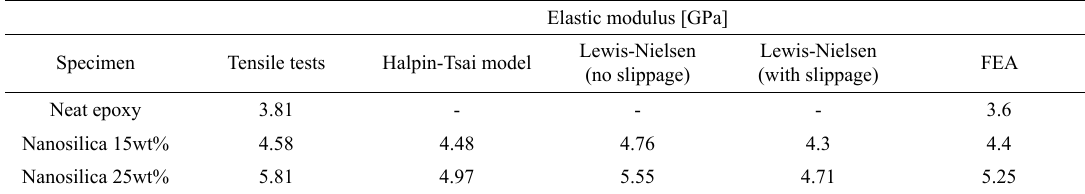
Table 1. Comparison of the elastic moduli of the specimens determined with tensile tests, arithmetic and numerical